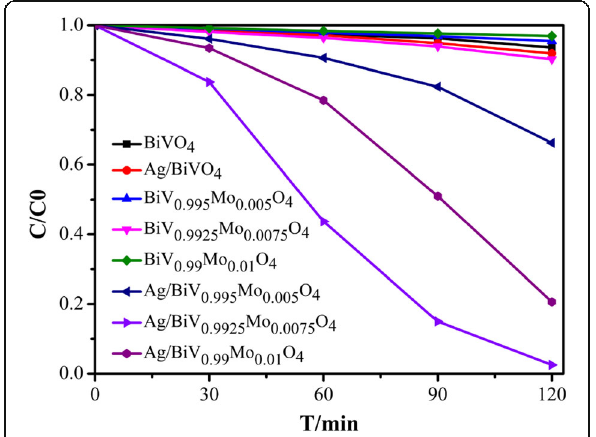
Fig. 8 Photocatalytic degradation of RhB by BiVO 4 , Ag/BiVO 4 , BiV 1-